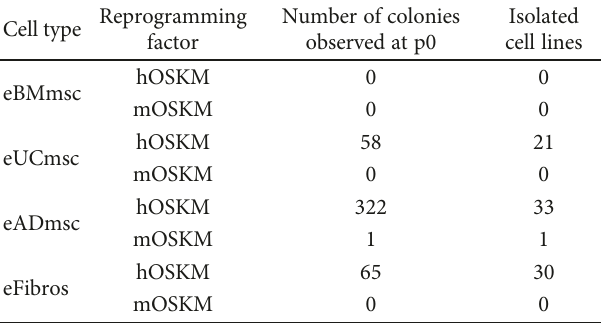
Table 3: Total number of eiPSC colonies produced and cells lines isolated from eBMmsc, eUCmsc, eADmsc and eFibros using human (hOSKM) and murine (mOSKM) reprogramming